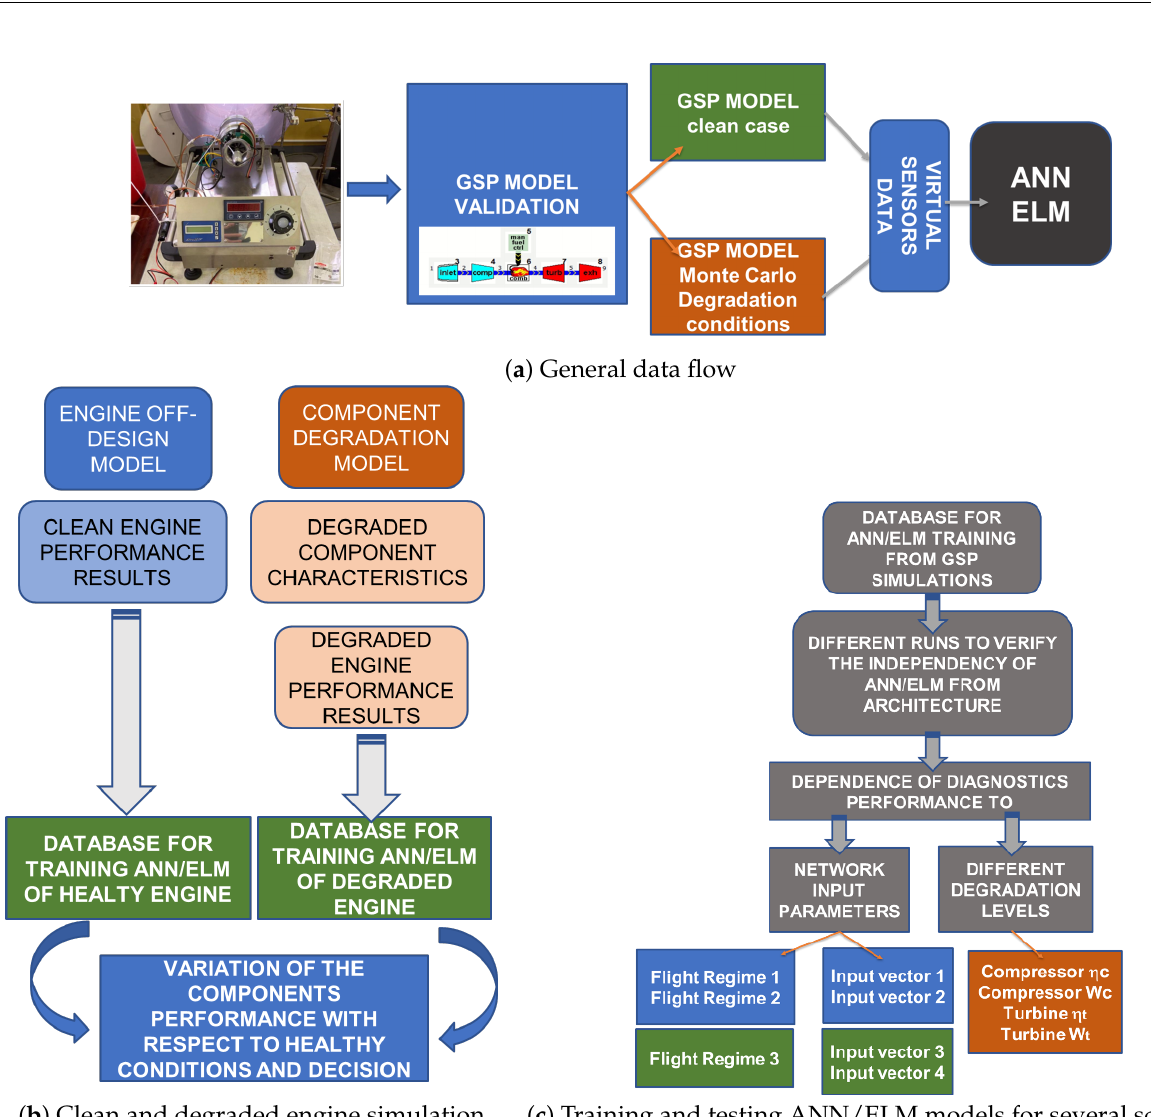
Figure 2. Methodology for component degradation